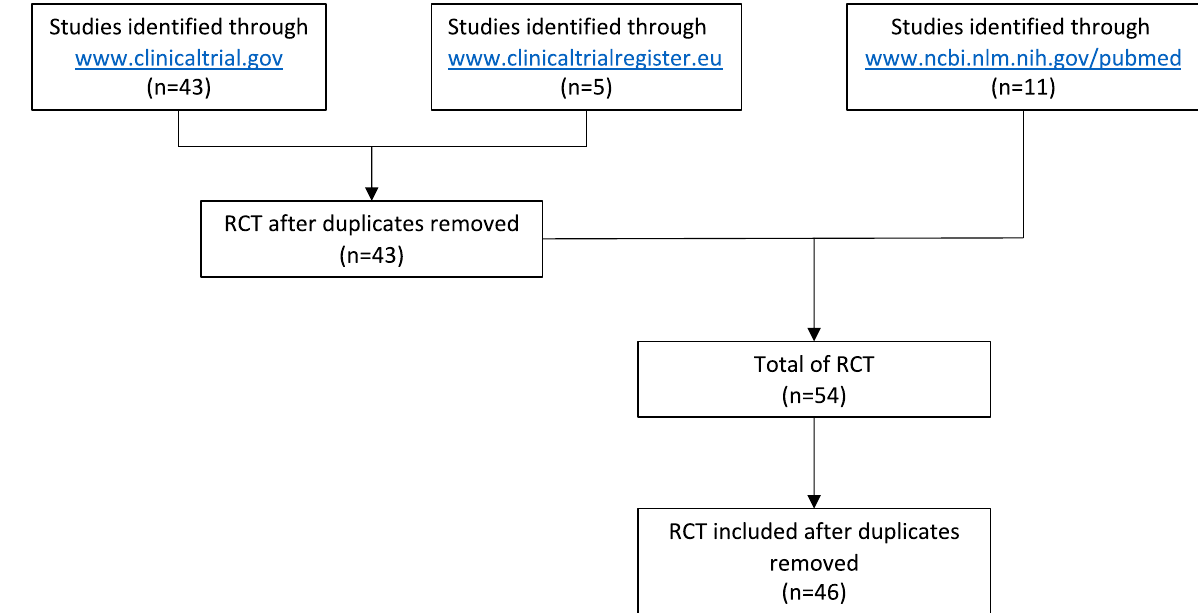
Figure 1: Chart flow for the study